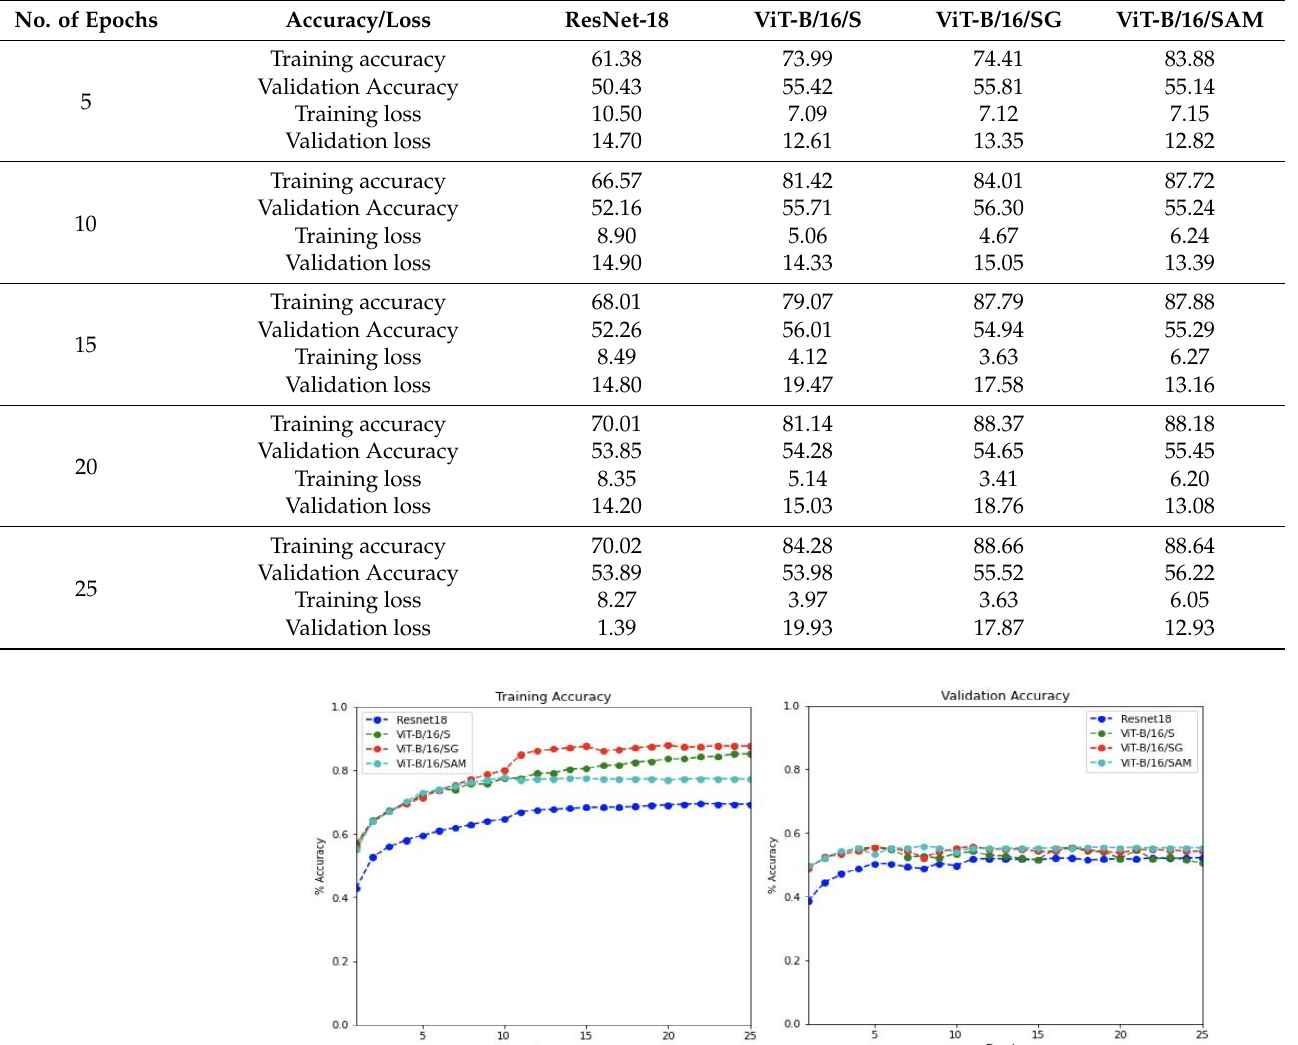
Table 2. Accuracy and loss of various models on different configured parameters.